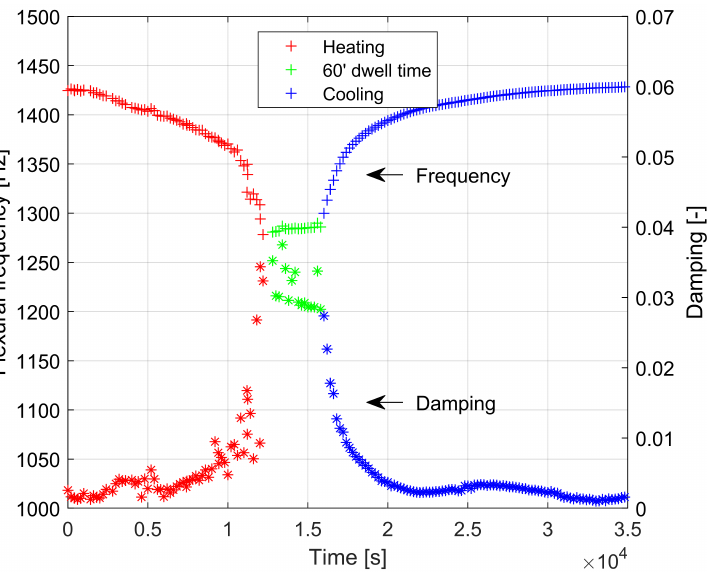
Figure 8. Dependencies of flexural frequency and damping versus time during heating and cooling of soda lime glass with 60 min of dwell time at 873